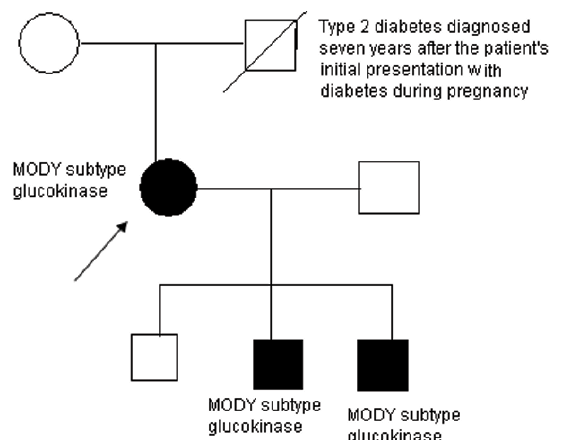
Figure 1. Family tree including the affected mother and her two